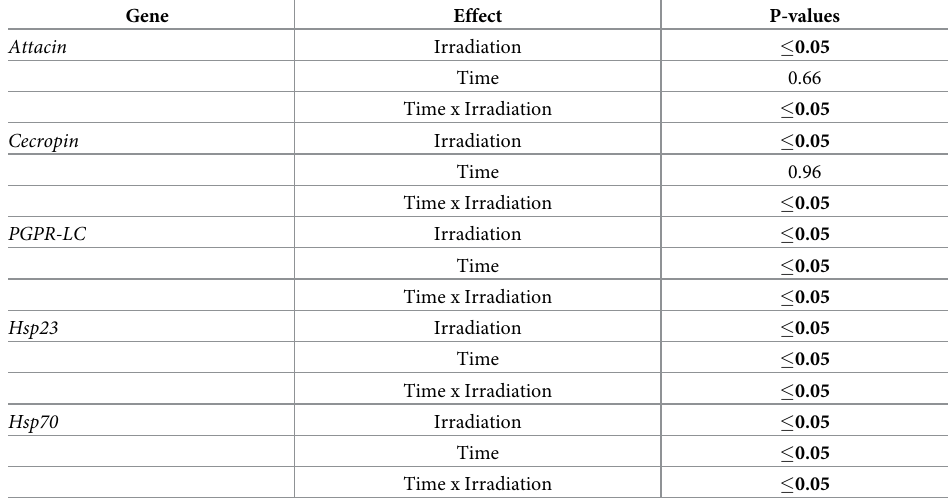
Table 2. Statistical analysis of the level of expression of attacin , cecropin , PGPR-LC , hsp23 and hsp70 gene, after treatment of medfly males with irradiation by using multifactor ANOVA (P � 0.05).